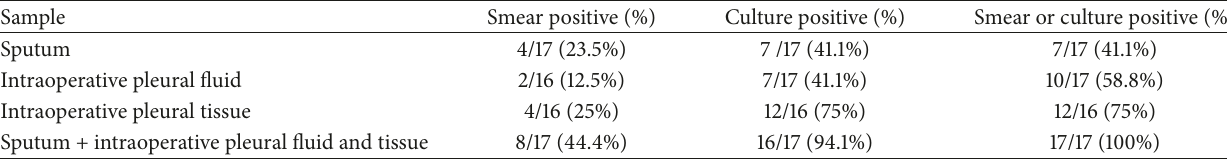
Table 3: Diagnostic yield of mycobacterial smear and culture.